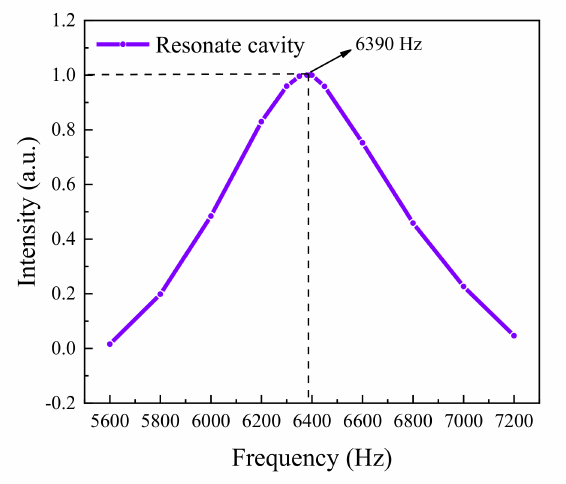
Figure 2. Frequency response of the acoustic resonate cavity inside the PA